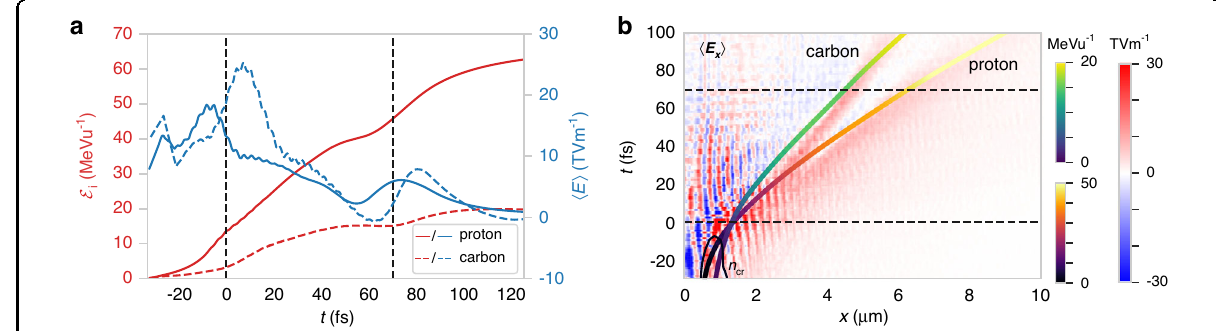
Fig. 5 Acceleration of most energetic particles for optimum target thickness. a Time history of kinetic energy E i (red) and local electric fi eld 〈 E 〉 (blue) experienced by exemplary proton (solid lines) and carbon ion (dashed). b Time history of 〈 E x 〉 along x lineout through the region of largest accelerating gradient, with overlaid trajectory of the same proton and carbon ion. The solid black line shows the n cr contour. Black dashed lines indicate the time of the two snapshots in Fig.